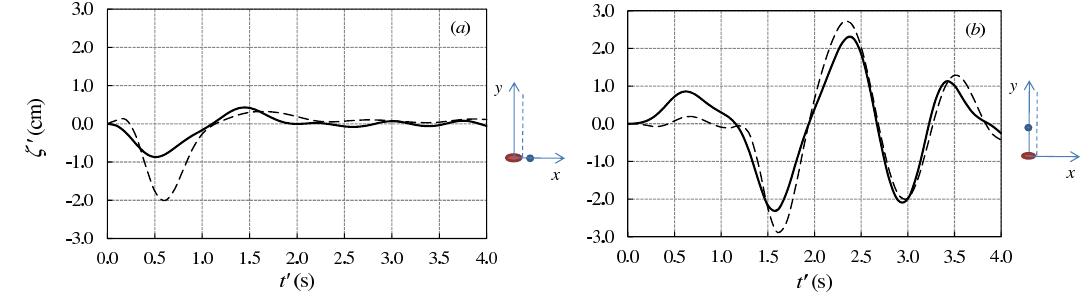
Fig. 12. Time series of the free-surface elevation in physical variables at points: (a) : (x 0 ,y 0 ) = ( 0 . 4 , 0 ) m, and (b) : (x 0 ,y 0 ) = ( 0 , 0 . 8 ) m. Solid lines (–) represent the time series for the semi-plane beach of horizontal length b = b 0 /σ = 1, while dashed lines (- -) are relevant to the indefinite plane beach model.